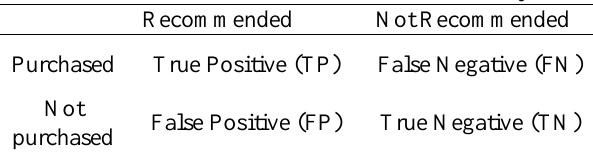
Figure 3. Recommendation evaluation process. Table 2. Confusion Matrix for recommendation